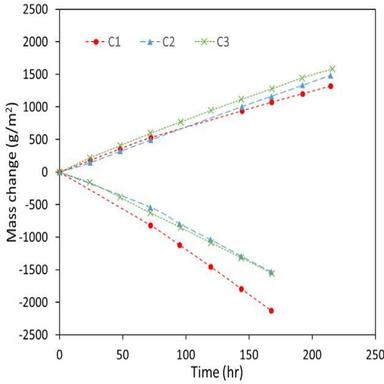
Mass change of the specimens during the vapour permeability test.